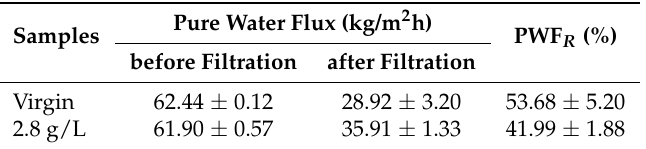
Table 7. Pure water flux before static adsorption of vanillin and after wood extract filtration for unmodified/modified UH004 P